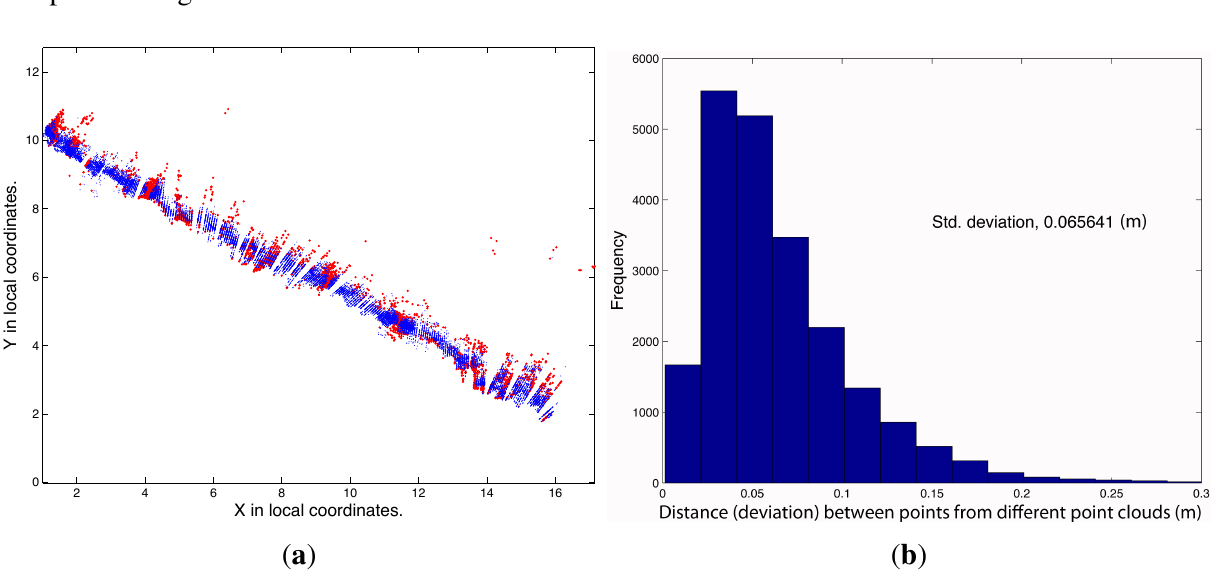
Figure 13. Comparison between linear path point cloud and zigzag path point cloud. ( a ) Zigzag point cloud and points with distances greater than 0.10 m (red points); ( b ) histogram of distances (deviations) between point clouds corresponding to linear and zigzag